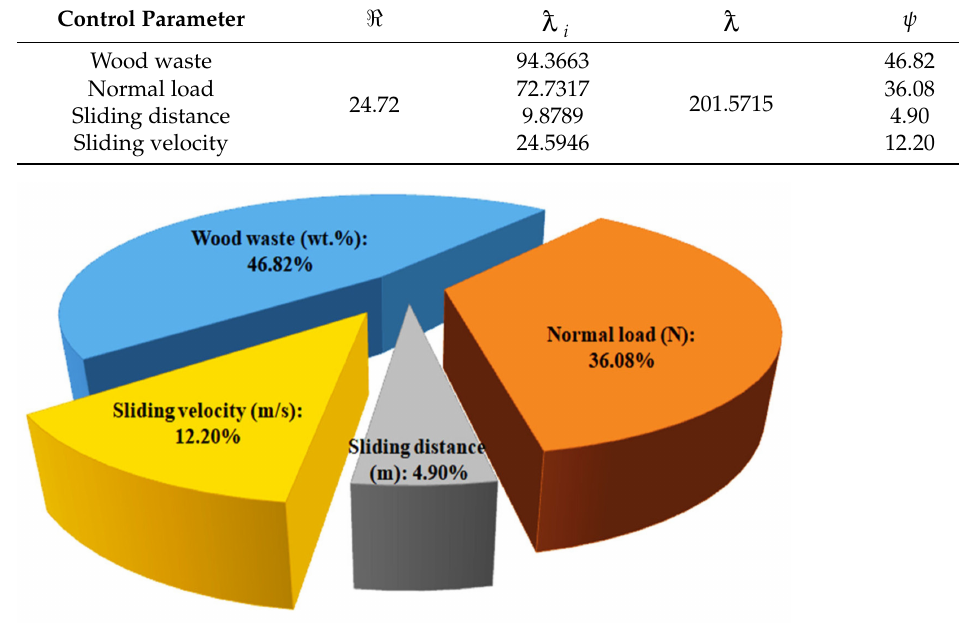
Table 6. Contribution ratio results. Control Parameter